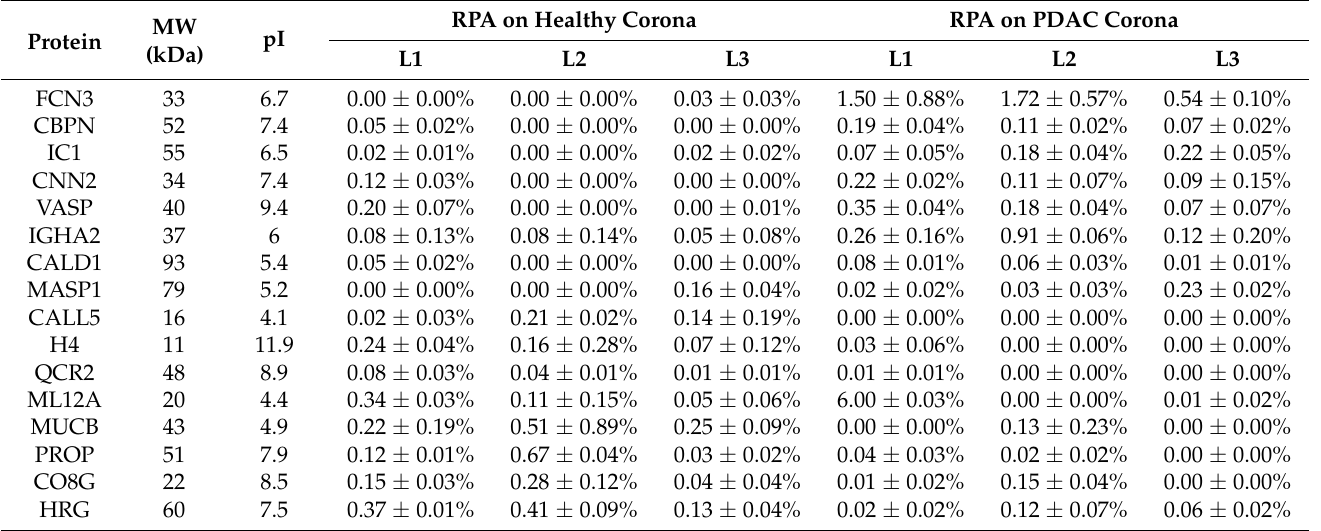
Figure 5. Scatter plot of the λ –values for L1, L2, and L3, as defined in Equation (1). Each protein is represented as a dot in the cubic box. Proteins located near the center populate almost equally healthy and cancer coronas for all the three liposomes. Conversely, proteins with larger RPAs in the PDAC coronas than the CTR ones are located in the top right corner and proteins with smaller RPAs in the PDAC coronas than the CTR ones are located in the bottom left corner. Table 4. Relative abundances of proteins which exhibited major differences between healthy and PDAC coronas, simultane- ously for all the employed